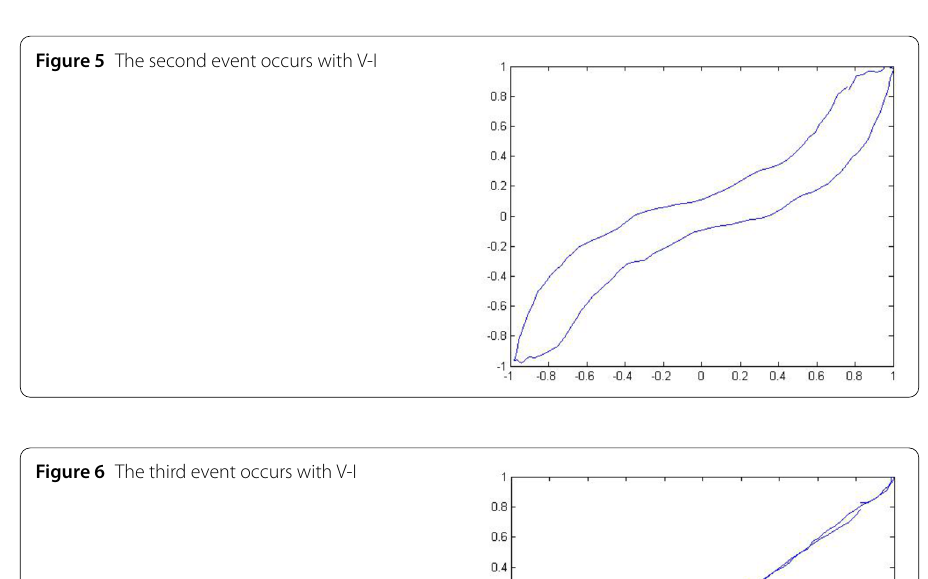
Figure 6 The third event occurs with